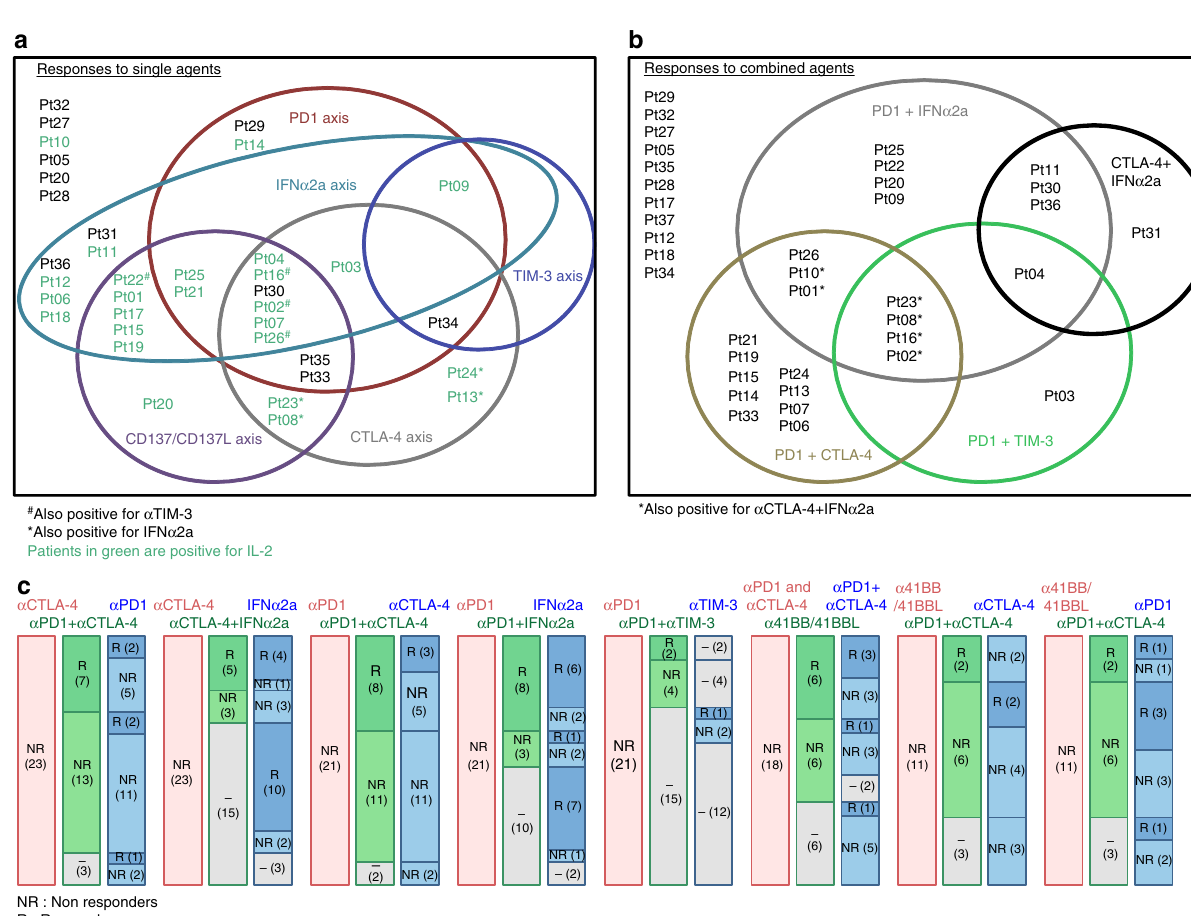
Fig. 2 Global representation of the patterns of responses to individual or combined stimulations for 37 MMel. a , b Venn diagram representing each stimulating axis alone a or in combination b per circle, patients being identi fi ed by letters and numbers. c Frequencies of patient lesions that failed to respond to a given axis ( fi rst bar , in red ) but could exhibit signi fi cant responses to alternative axis of stimulation. ( second and third bar in green and blue ). For instance ( very left bars ), in the non-responding lesions (NR) to anti-CTLA-4 Ab, we annotated the percentages that could respond (or not) to anti-CTLA-4 + anti-PD-1 Ab co-blockade (in green ), among which some of them could respond (or not) to anti-PD-1 Ab alone (in blue ). The detailed patterns of responses feature in Supplementary Table 1. In gray boxes : Not